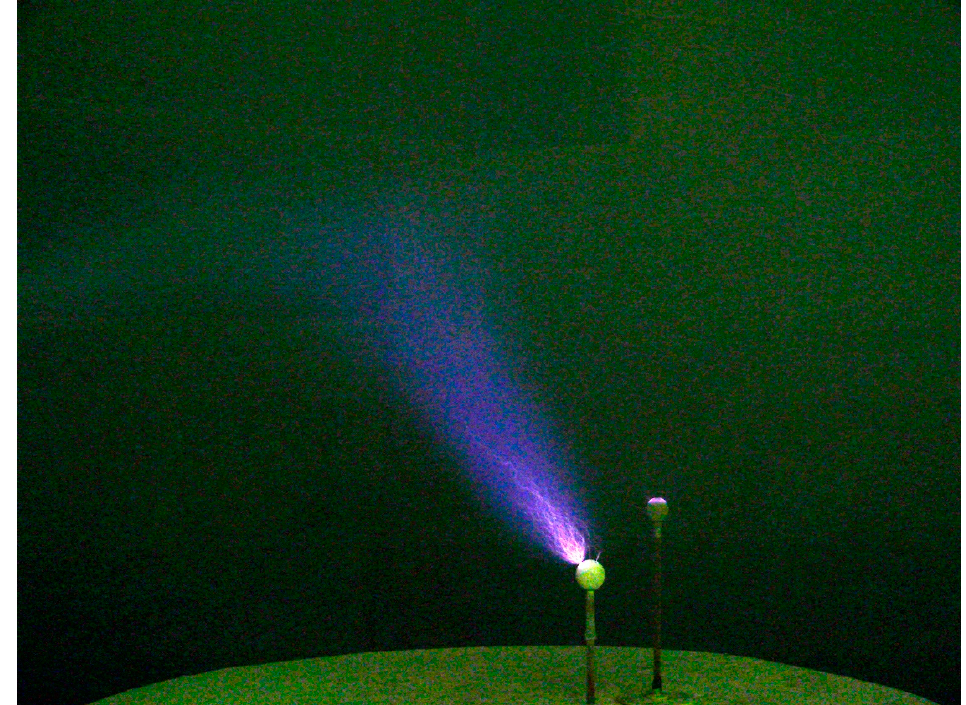
Figure 3. Upward streamer corona flash from the grounded rod model elements.